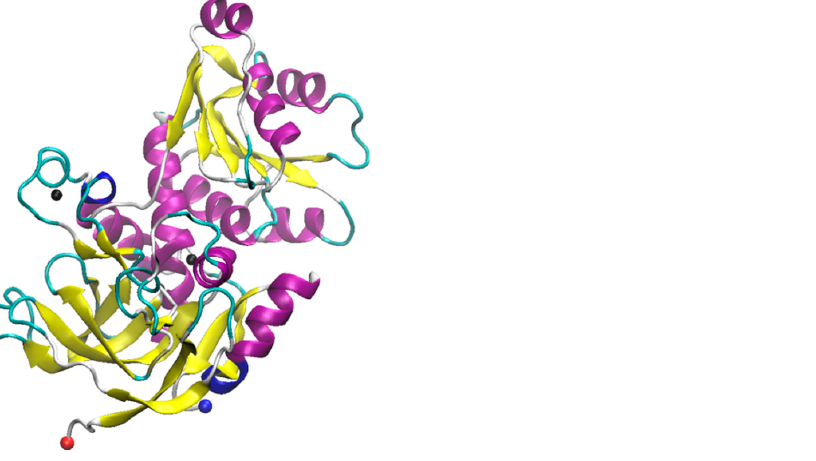
Figure 5. 3D Structure of alcohol dehydrogenase from Saccharomyces cerevisiae . The crystal structure was solved by Ramaswamy and coworkers; downloaded from rcsb.org (5ENV) ([145,193]. The structure was visualized using VMD. The N- and C-termini are shown as red and blue spheres respectively while the zinc ions are shown in black. The structure represents one monomer of a homotetramer .